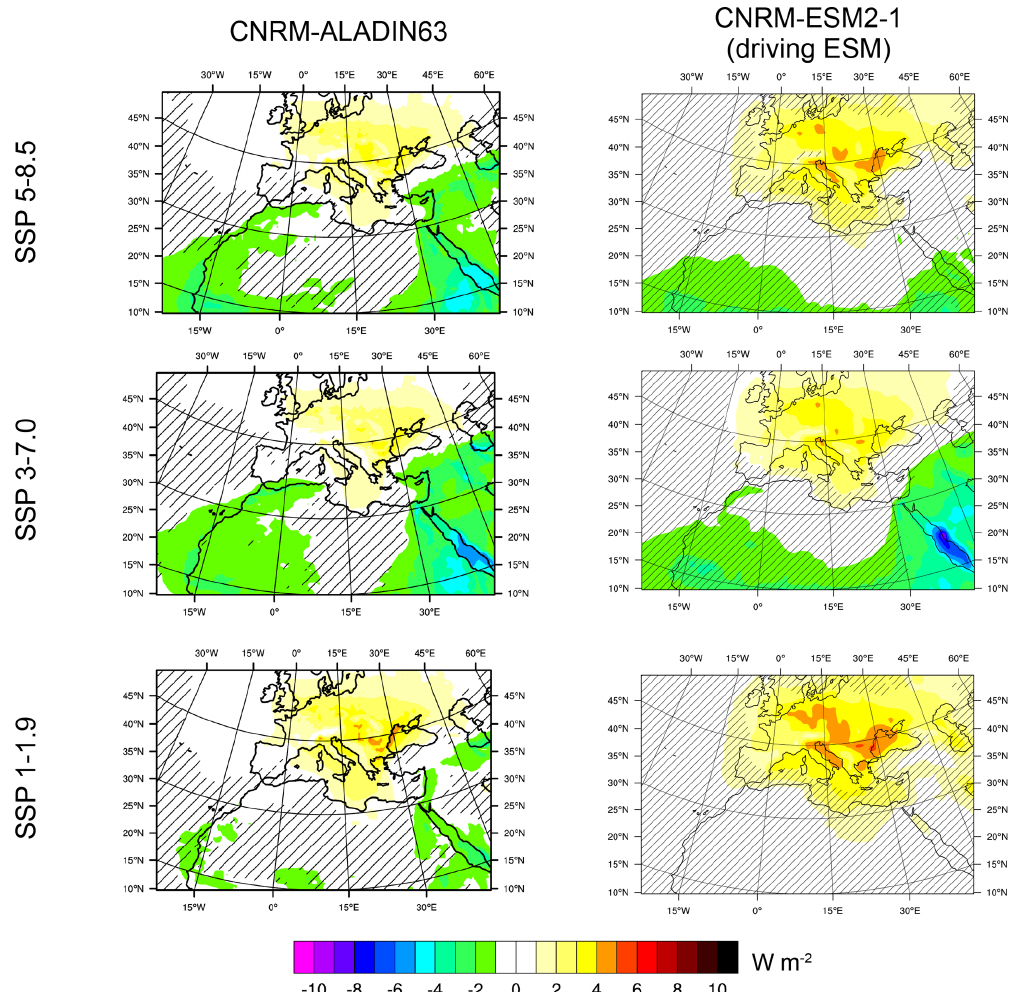
Figure A2. Surface SW DRF evolution between the past period (1971–2000) and the future period (2021–2050) with the CNRM-ALADIN63 model and its driving ESM. The hatched areas are statically non-significant with a threshold of